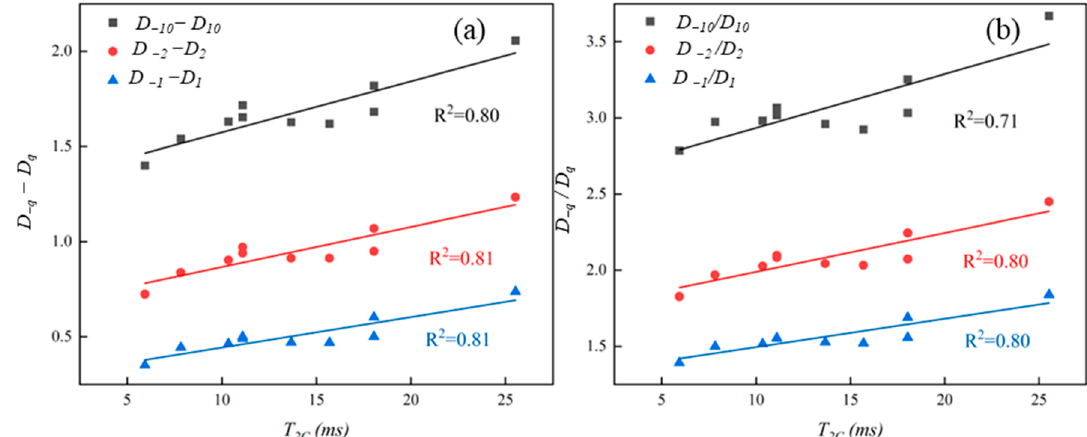
Figure 12. Relationship between T 2C and multifractal dimension of the ten modeling samples: ( a ) Relationship between T 2C and D − q − D q . ( b ) Relationship between T 2C and D − q / D q .